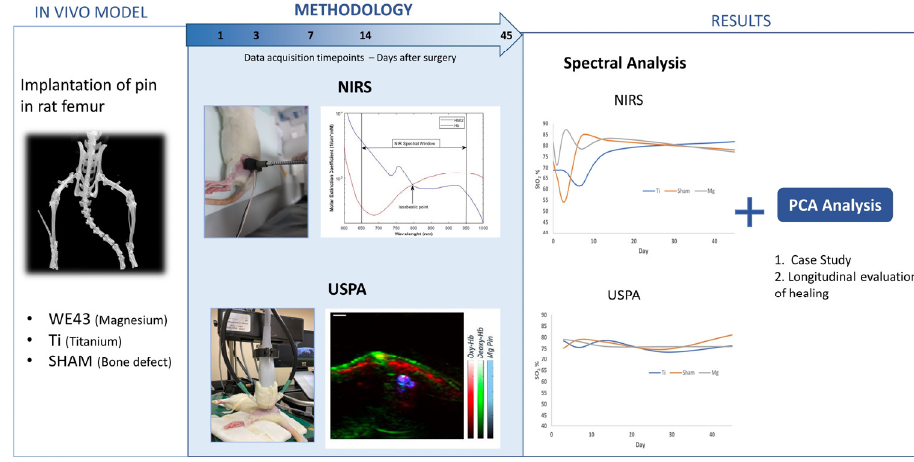
Figure 2. Illustration Summarizing the Workflow of the Study.